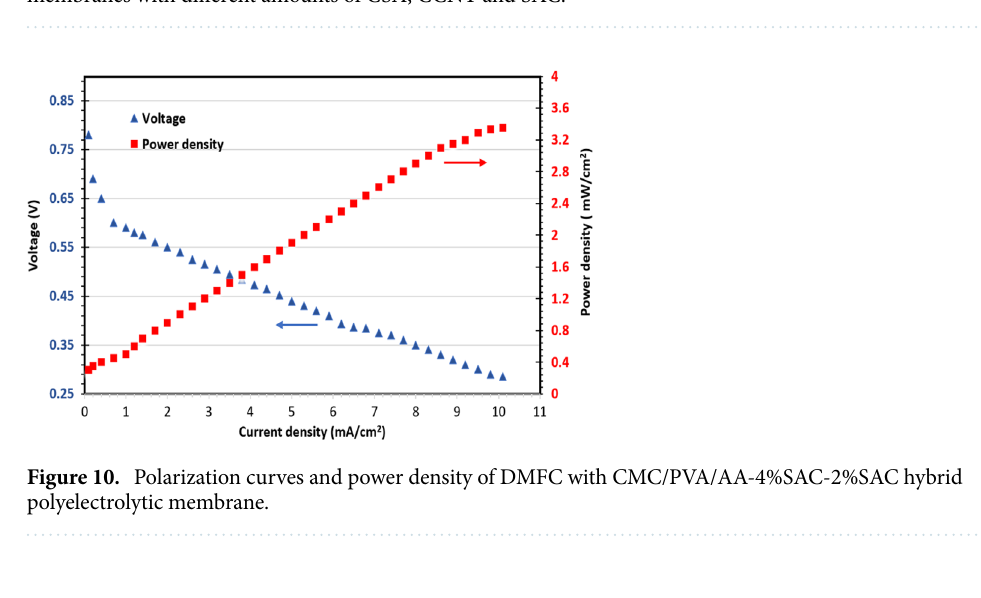
Figure 9. Thermogravimetric spectra of CMC/PVA/AA and modified CMC/PVA/AA hybrid polyelectrolytic membranes with different amounts of CSA, CCNT and SAC.